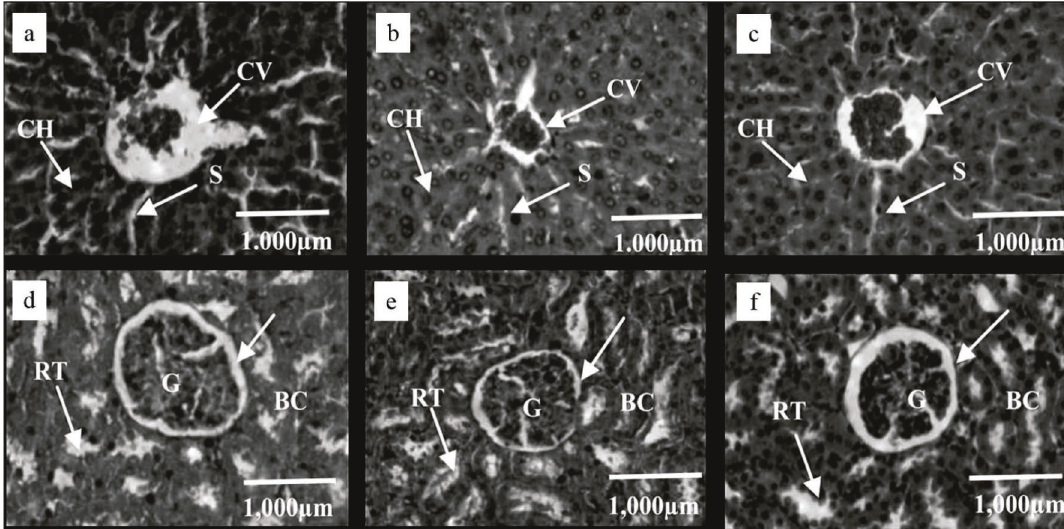
( c ) EEStb and of renal tissue 300 2.000 ( f ) EEStb . formalin fixed, HE- stained. CH – Cords of Hepatocyte; S - 300 2.000